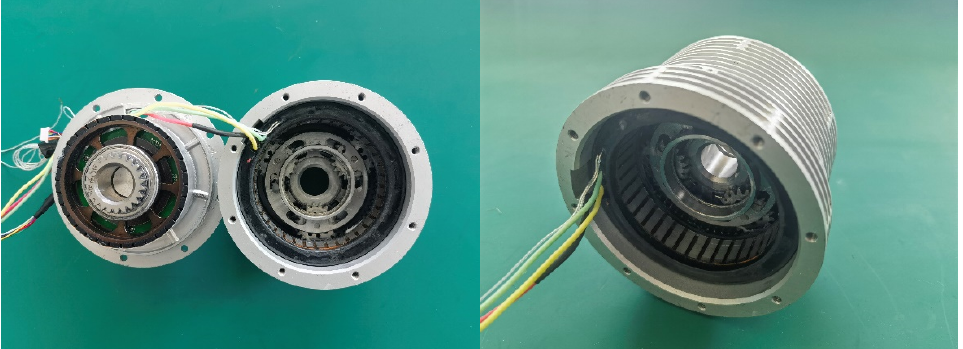
Figure 11. Diagram of physical prototype.